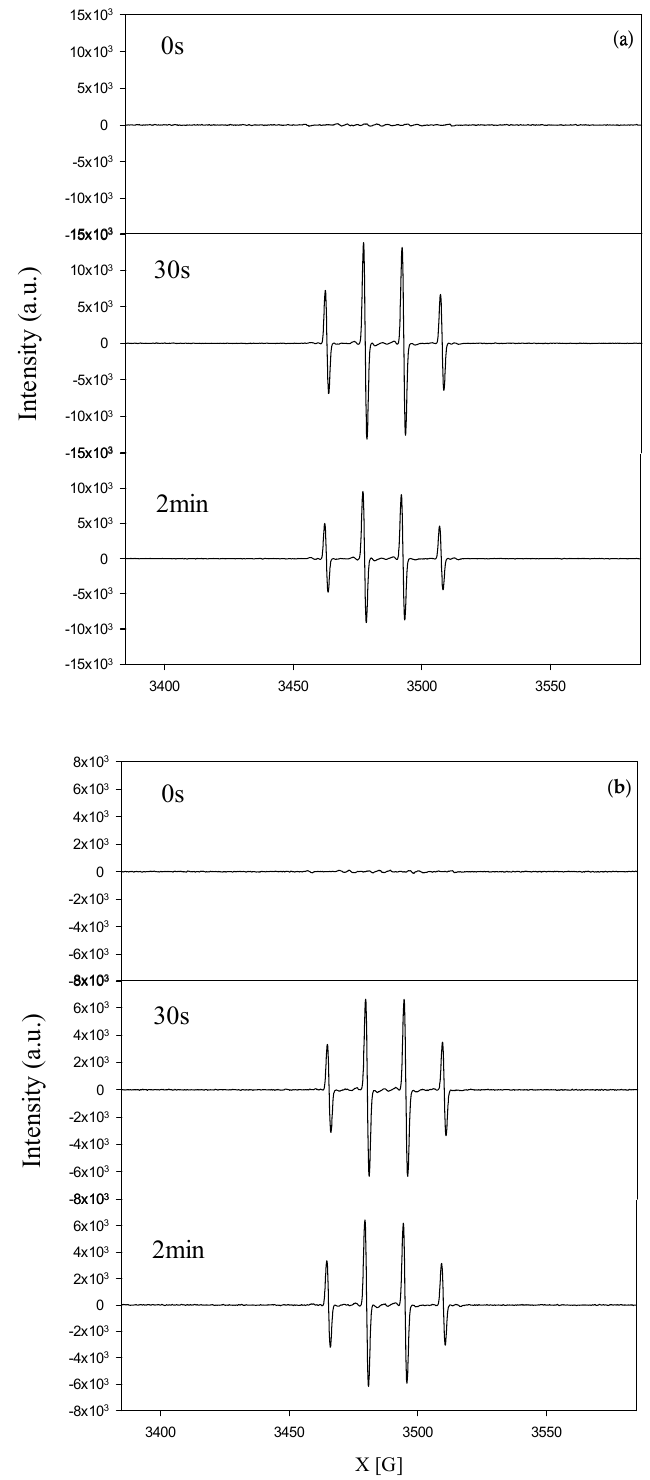
Figure 12. Electron paramagnetic resonance (EPR) signal of DMPO-OH compound under dark reaction and ultraviolet irradiation ( a ) TNAs and ( b ) Pd/TNAs.